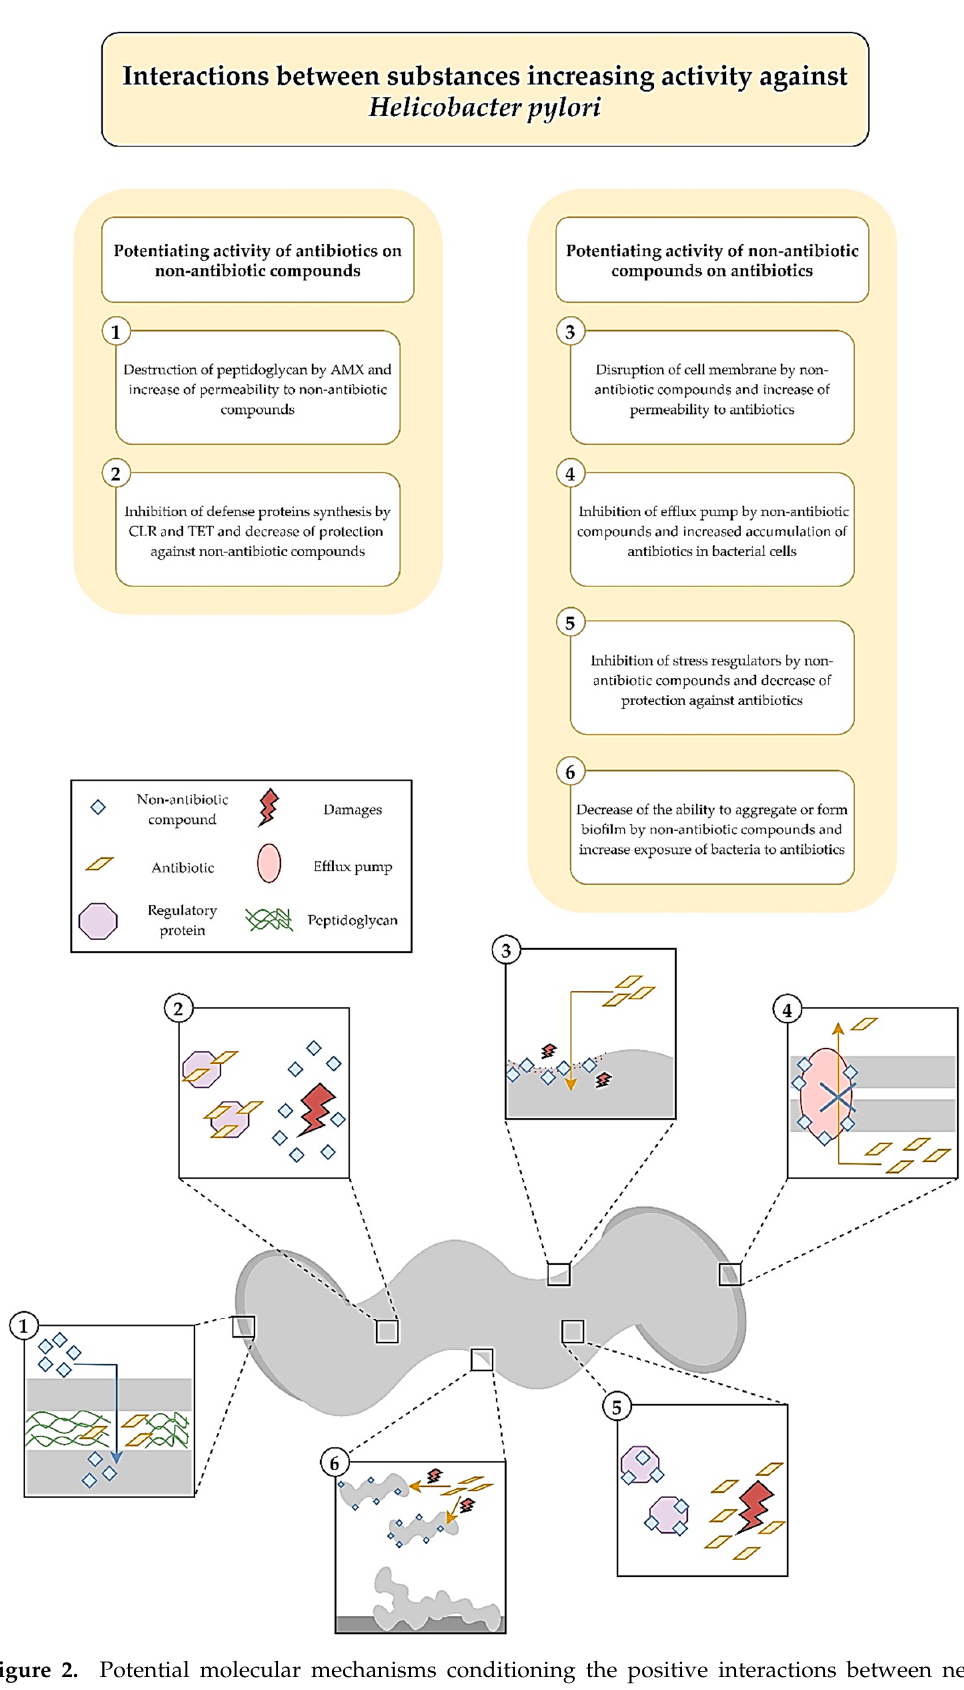
Figure 2. Potential molecular mechanisms conditioning the positive interactions between new non-antibiotic compounds and classically used antibiotics against H. pylori .